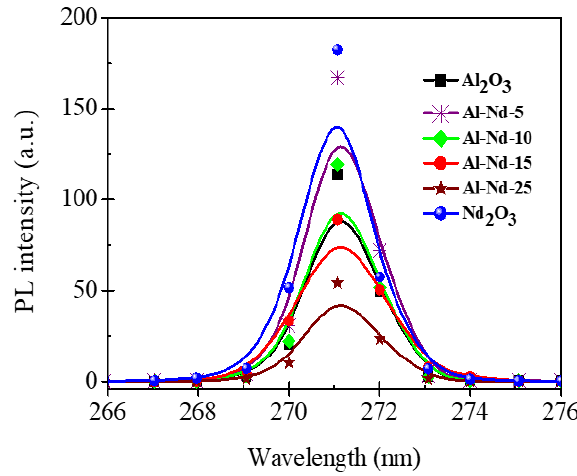
Figure 12. PL spectra of γ -Al 2 O 3 , Al-Nd- x binary oxides and Nd 2 O 3 .